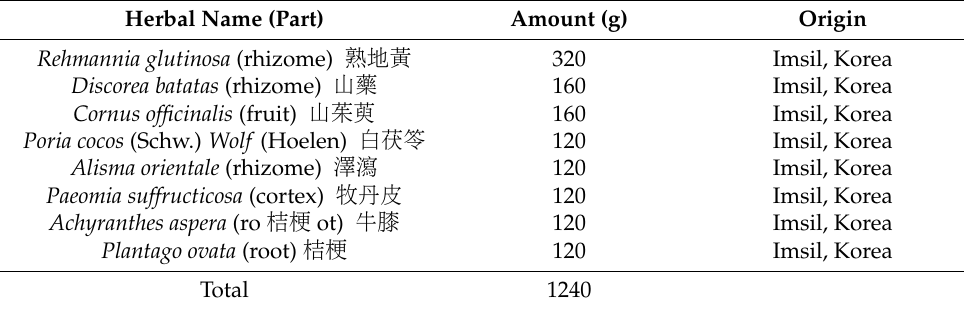
Table 1. Decoction of Geumgwe-sinkihwan (GSH). Herbal Name